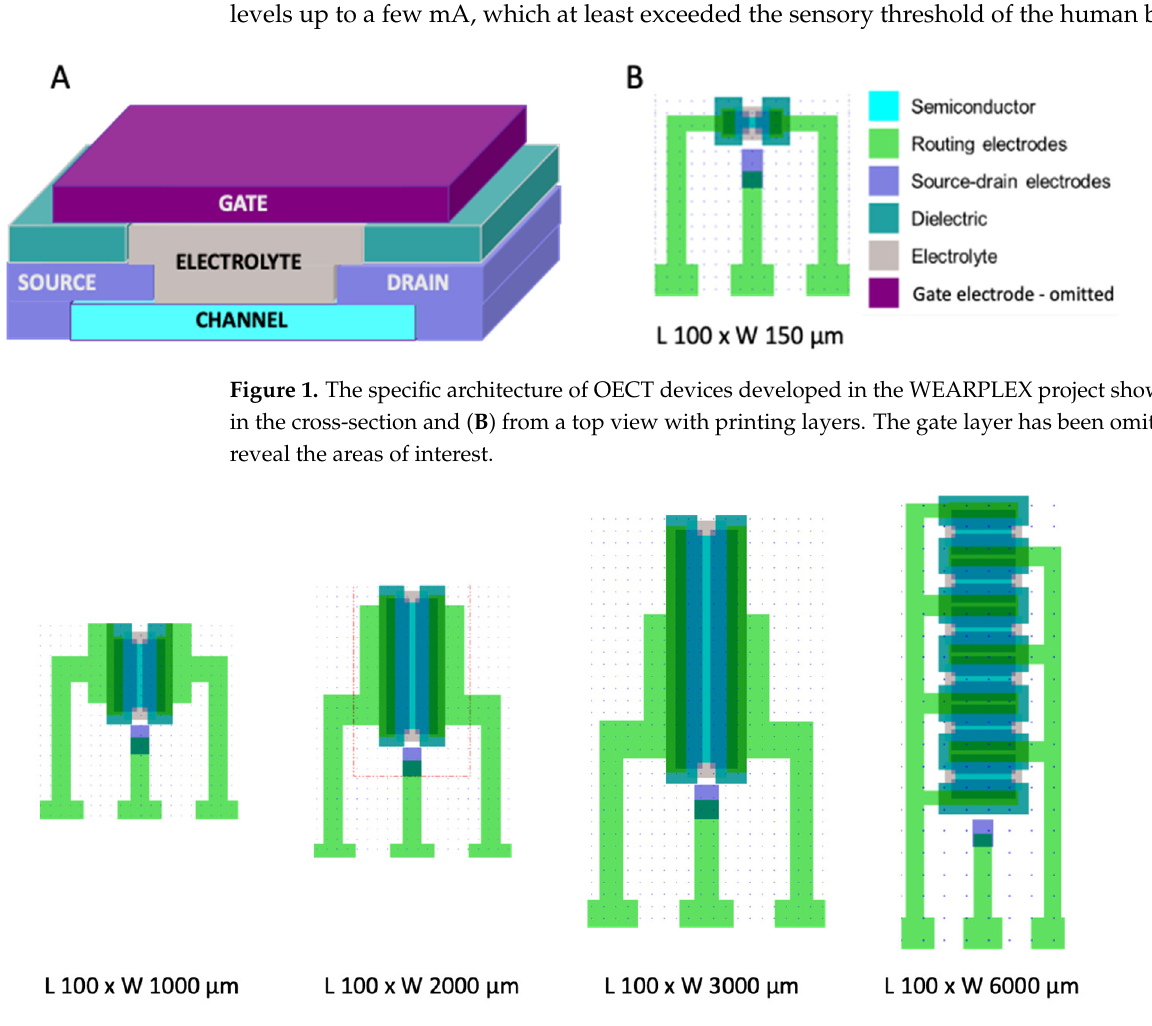
Figure 1. The specific architecture of OECT devices developed in the WEARPLEX project shown ( A ) in the cross-section and ( B ) from a top view with printing layers. The gate layer has been omitted to reveal the areas of interest.